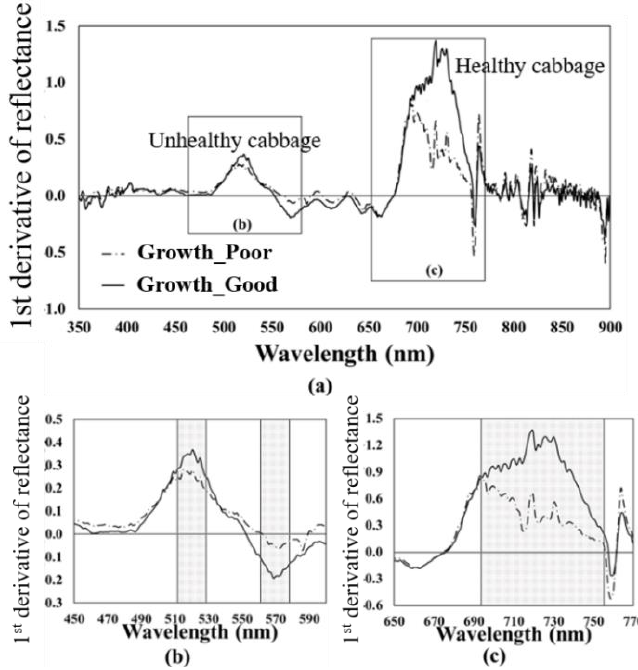
Figure 7. Comparison of the first derivative of the spectral reflectance of healthy and unhealthy cabbages based on wavelength. ( a ) Figures show that the wavelengths between 450–600 nm ( b ) and 650–770 nm ( c ) were most sensitive to PRI and chlorophyll status detection.